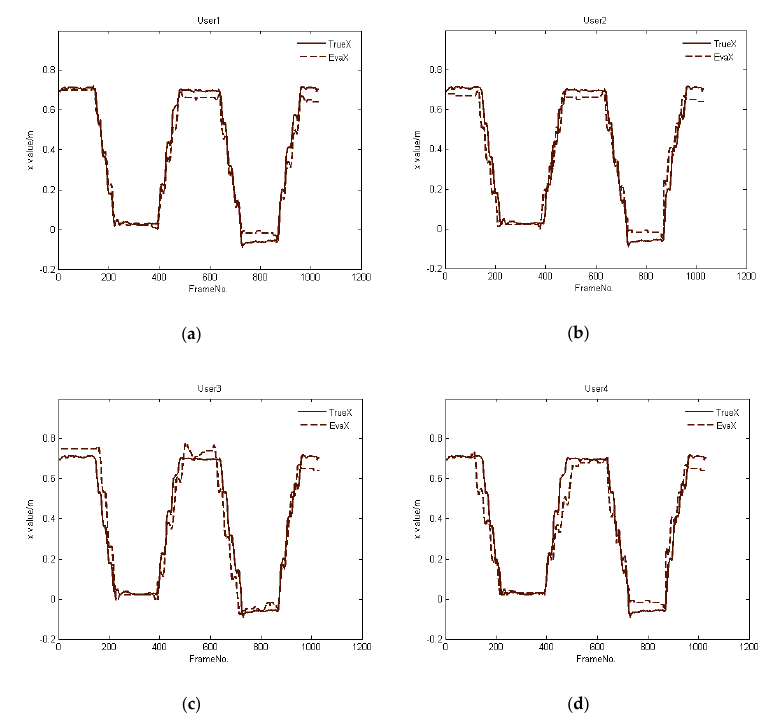
Figure 13. Comparison between trajectories as tracked by a person’s skeleton as opposed to computed using shadows for Path 2, where Users 1, 2, 3, and 4 are randomly selected human participants, and their tracking results correspond to ( a – d ), respectively.